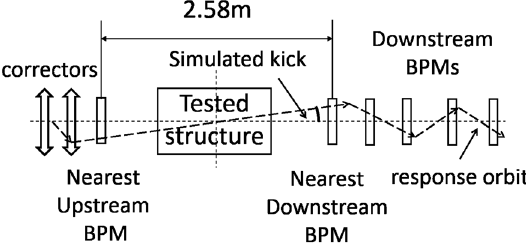
FIG. 4. R − 12 (response orbit) measurements by simulating the wake kick using upstream